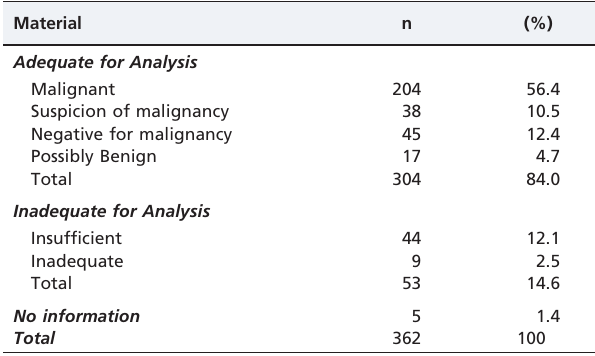
Table 1 - Cytological analysis results of 357